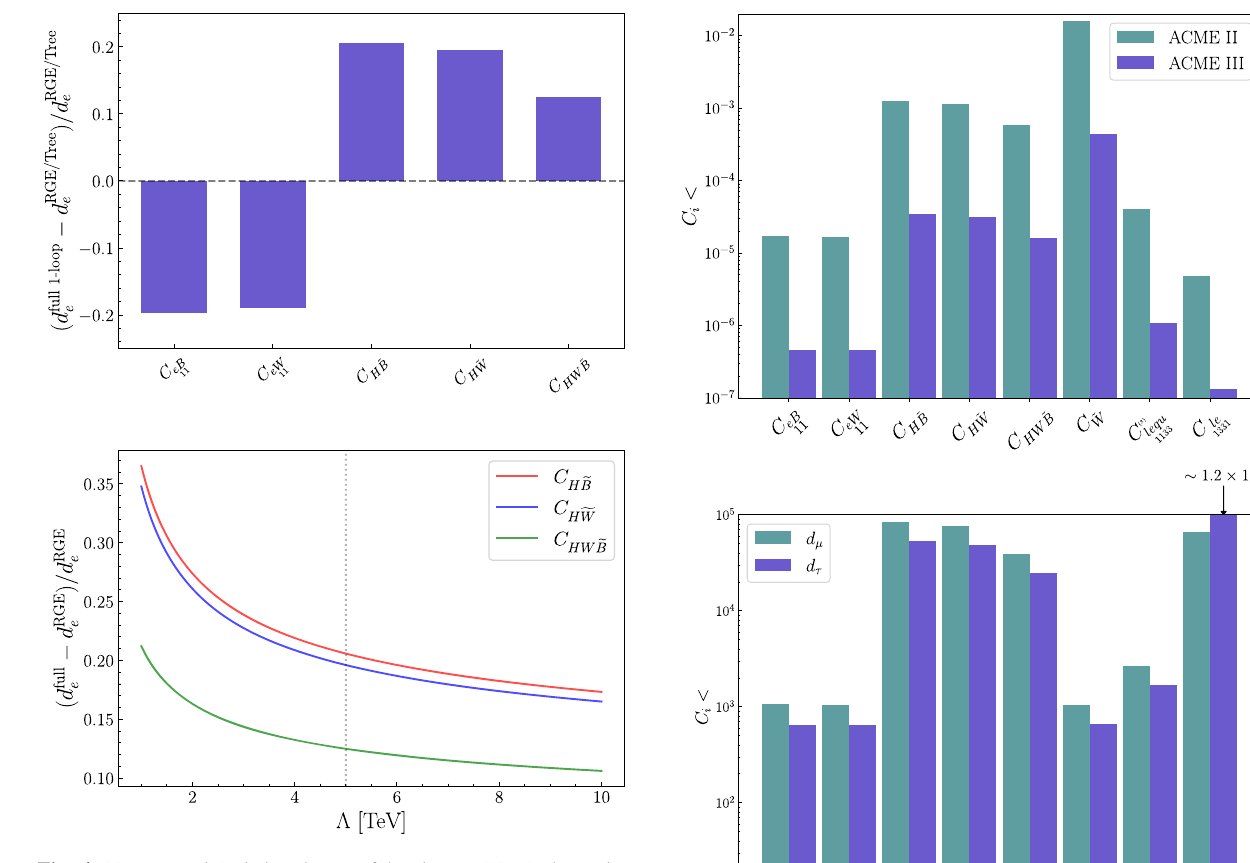
Fig. 4 Upper panel: Relative change of the electron EDM when using the full 1-loop result compared to only the RG running ( H 2 F 2 oper- ators) and impact of the full 1-loop effects compared to the tree level term ( F ψ 2 H operators). Lower panel: Dependence of the relative shift in the EDMs as a function of the scale (cid:2). Here the dotted line shows the benchmark value of (cid:2) = 5 TeV used in this paper